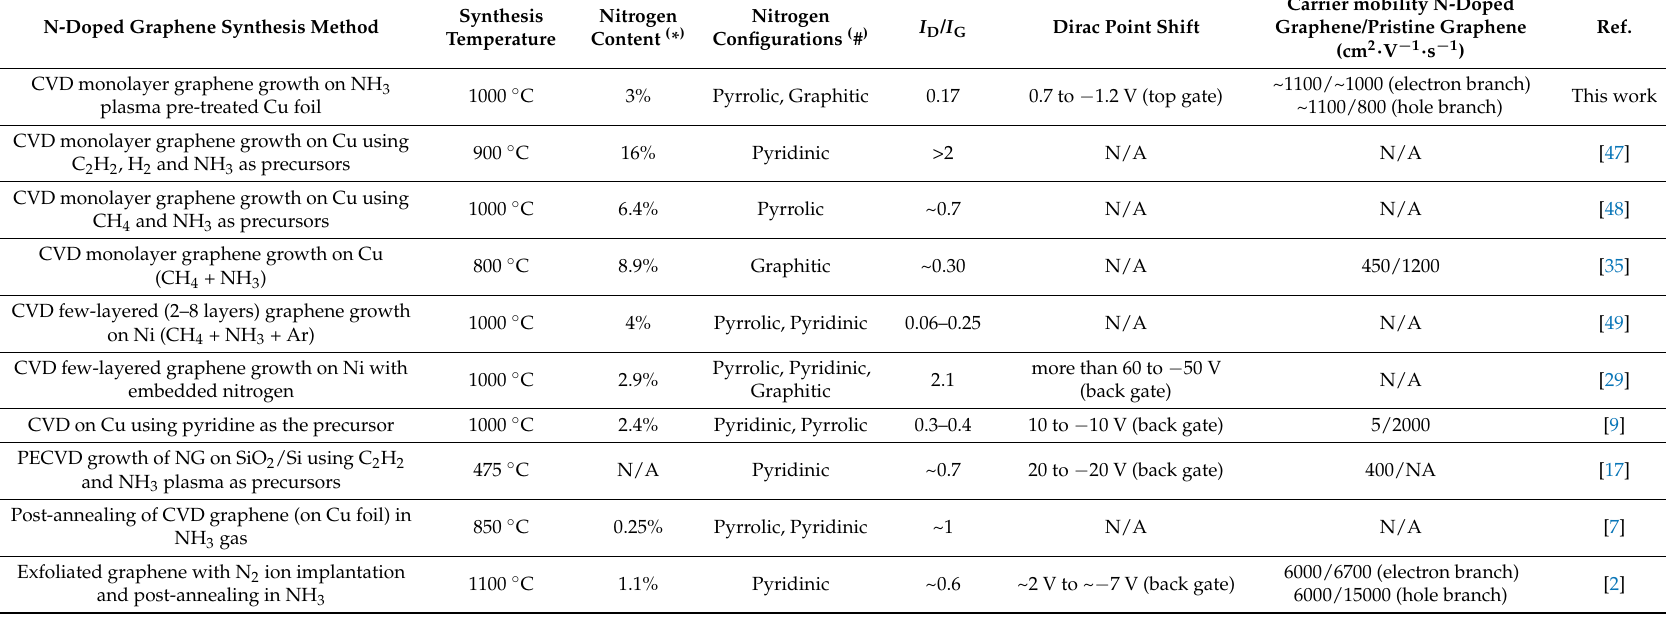
N-Doped Graphene Synthesis